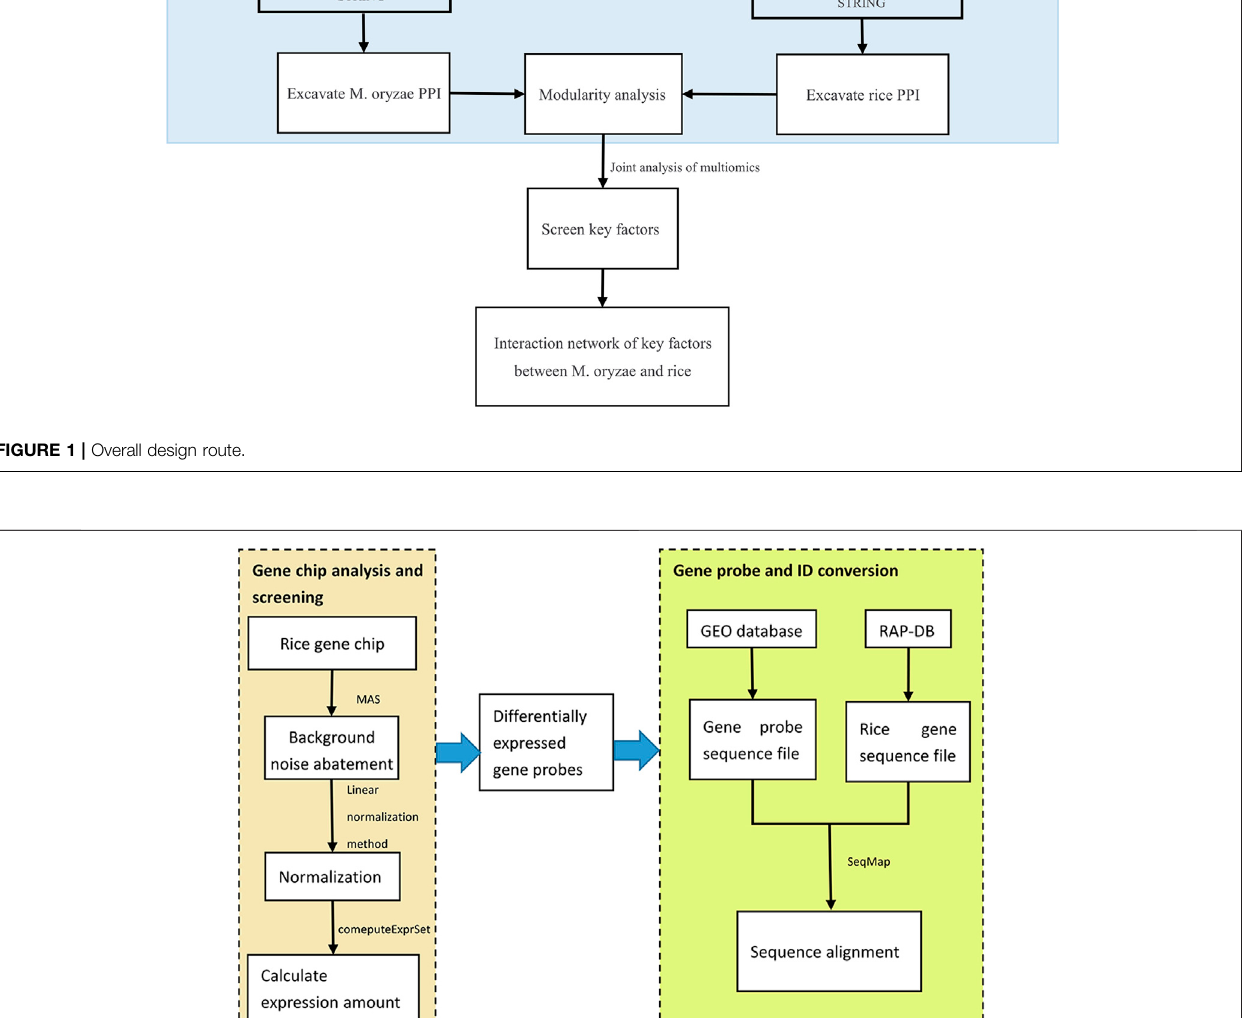
FIGURE 2 | Algorithms for the analysis of differentially expressed